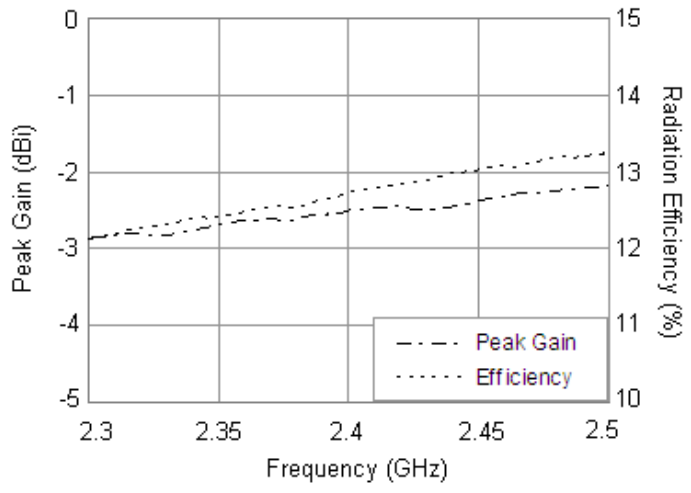
Figure 12. Measured peak gain and radiation efficiency of the antenna along with the installation